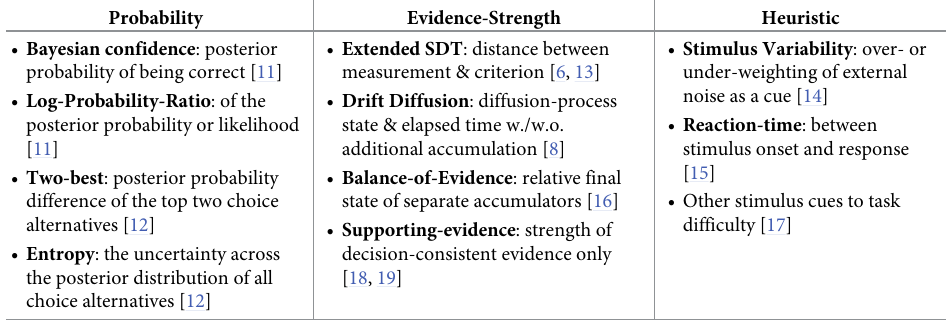
Table 1. Some implementations of the three most common confidence metric types used for modelling perceptual confidence and example study that used this model.